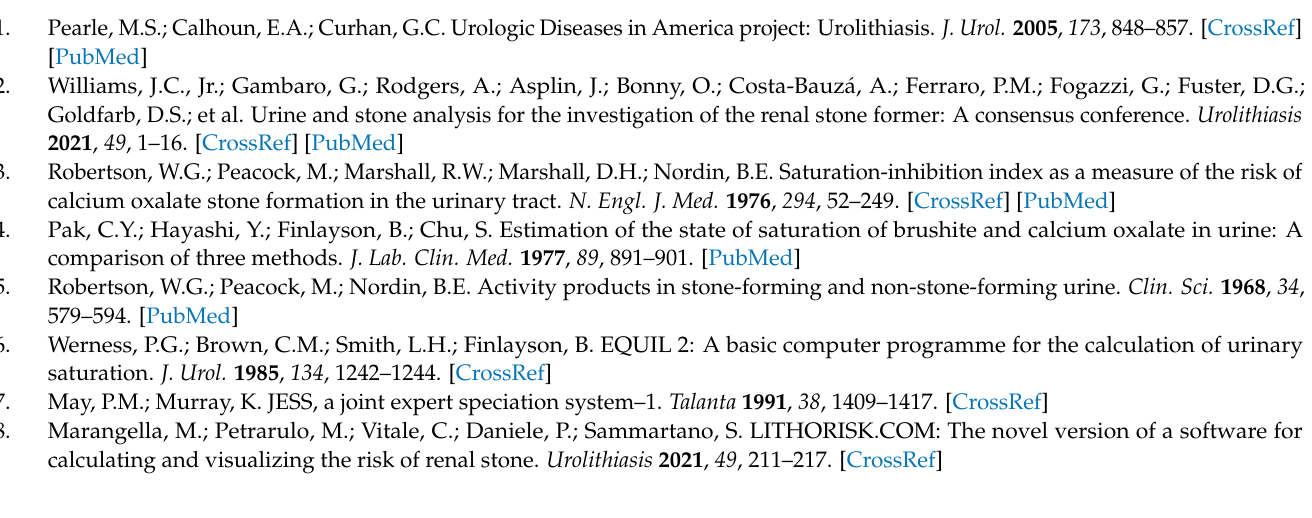
Supplementary Materials: Table S1: pH and concentrations of the components of the urine samples, Table S2: formation constants of the species considered to model real urine samples, Figure S1: speciation plots for the urine A and C, Figure S2: speciation plots for the urine D and E. Paragraph: Saturation level